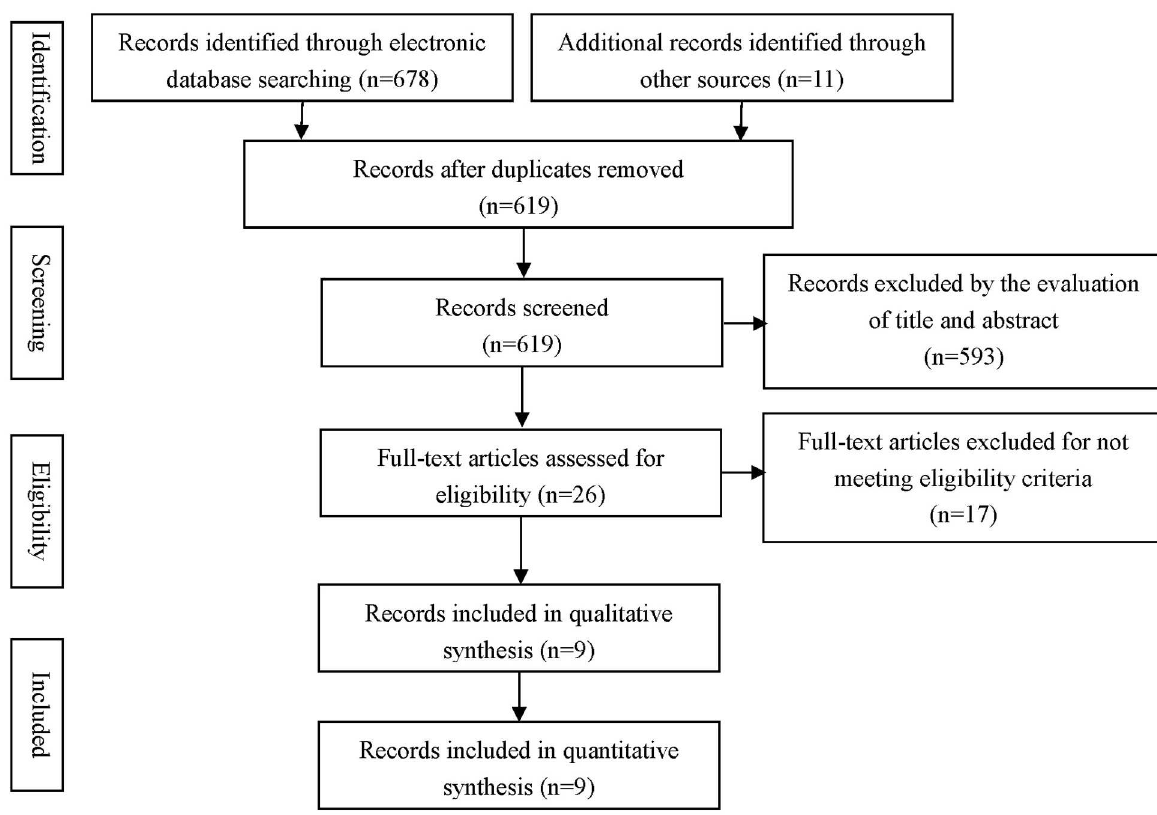
Fig 1. Flow diagram of the study selection